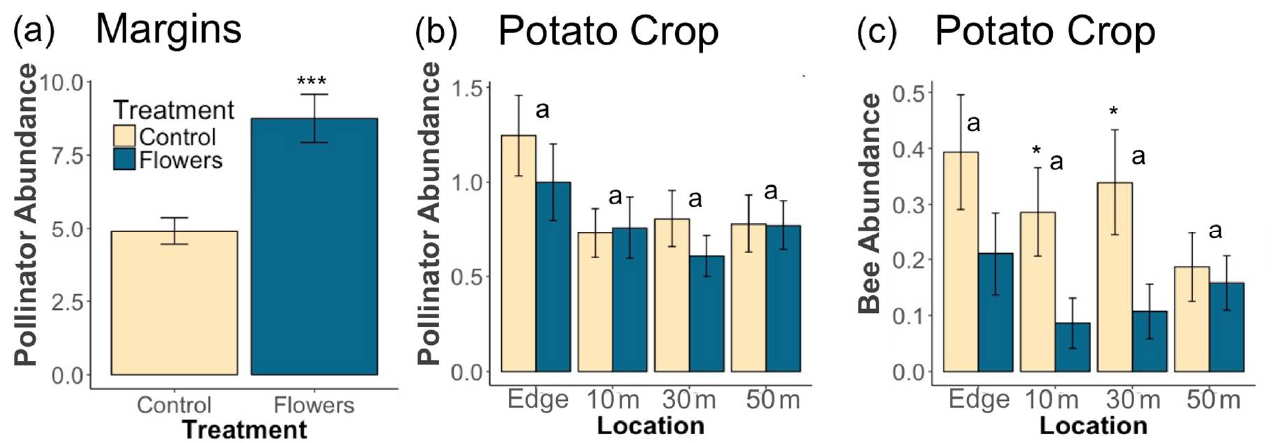
Figure 2. Mean ( ± 1 SE) abundance of ( a ) pollinators in field margins, ( b ) pollinators within potato crops, and ( c ) bees within potato crops. Asterisks denote significant differences between treatments at each location (* p < 0.05, *** p < 0.001). Letters denote significant differences in overall abundance between locations. Table 1. Pollinator abundance, z values, and significance by treatment and floral cover within field margins. Bolded values are significant ( p < 0.05). Taxa with fewer than 10 individuals were not